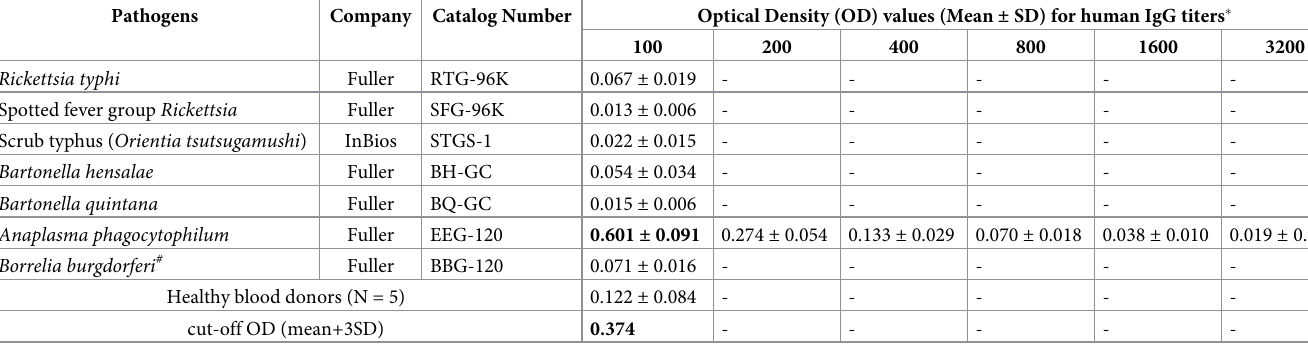
Table 3. The cross-reactivity of the in-house ELISA assay to vector-borne diseases previously reported in Thailand.